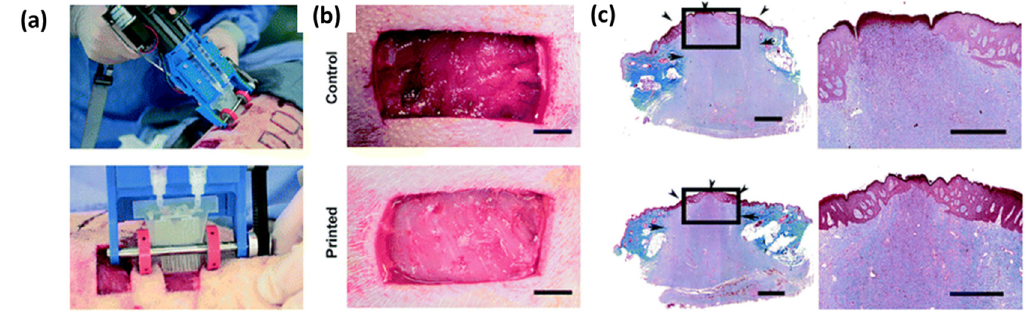
Figure 7. ( a ) Photograph of the printing of a biopolymer sheet in porcine wound. ( b ) Difference between the control (without biopolymer sheet) and the wound filled with a biopolymer sheet after 5 min. Scale bar: 2 mm. ( c ) Re-epithelialization assessed by trichrome staining between control (top images) and wound filled with biopolymer sheet (bottom images), scale bar 2 mm (left), and 1 mm (right). Adapted with permission from Hakimi et al . [218].